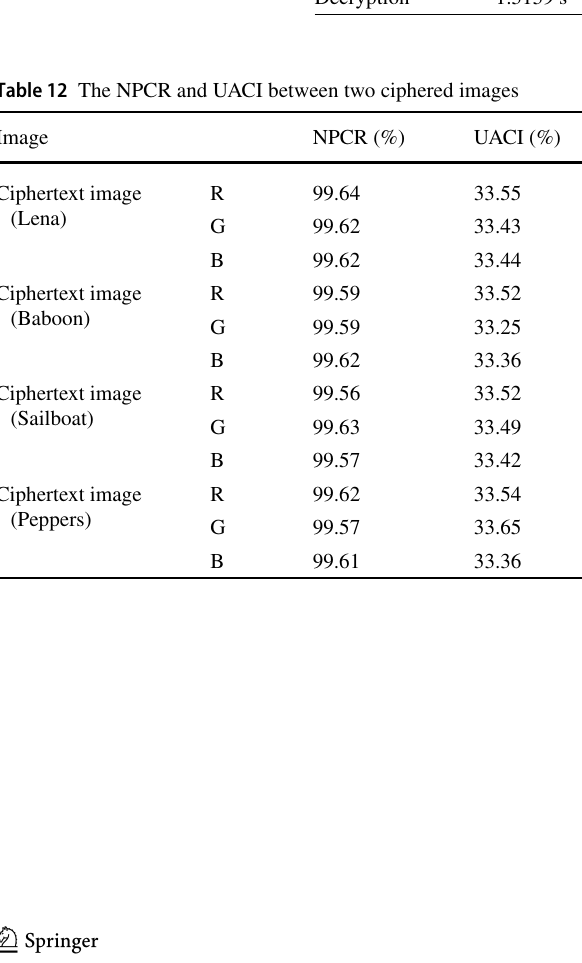
Table 11 Encryption and decryption time for 256 × 256 color images